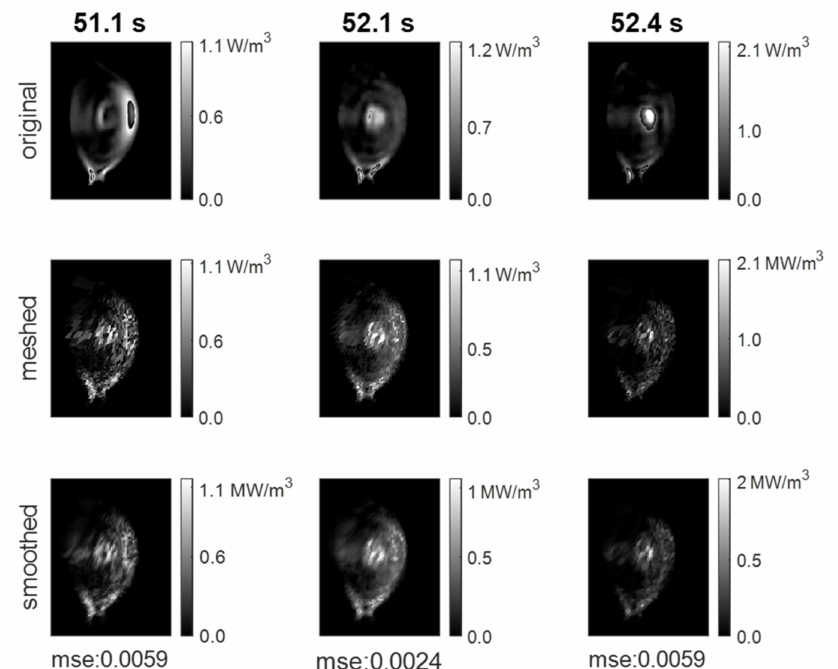
Figure 10. Tomographic reconstructions of three frames in the interval [51.1 s–52.5 s]. In the three rows: the original images (top row), the meshed reconstructions (midrow), and the smoothed solutions (bottom row) are reported. The instants of occurrence of the frames are reported on the top, whereas the values of mse are reported on the